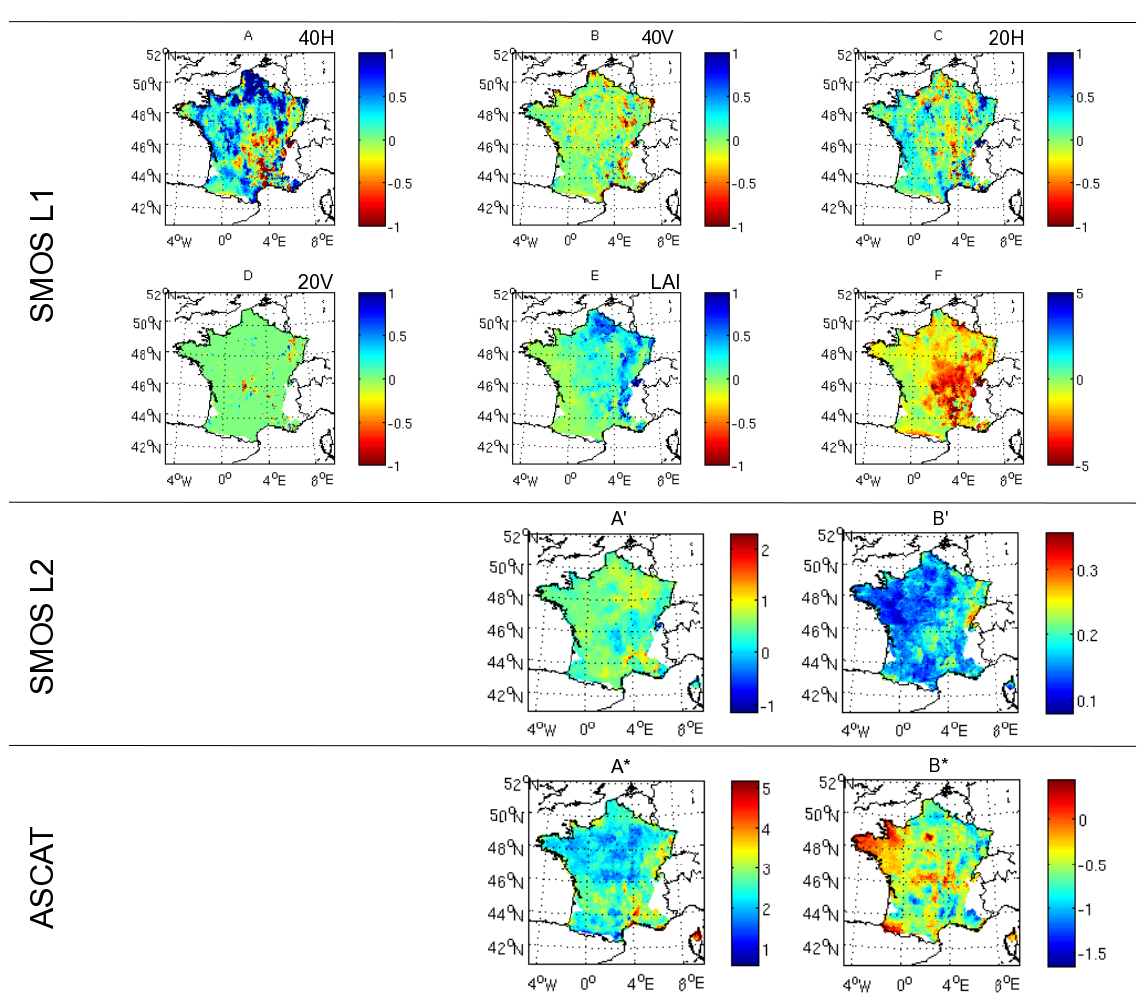
Fig. 8. Regression coefficients of satellite vs. ISBA-A-gs SSM in 2010: (top panels) SMOS-L1 with Eq. (2), (middle panels) SMOS-L2 with Eq. (3), (bottom panels) ASCAT with Eq. (4).